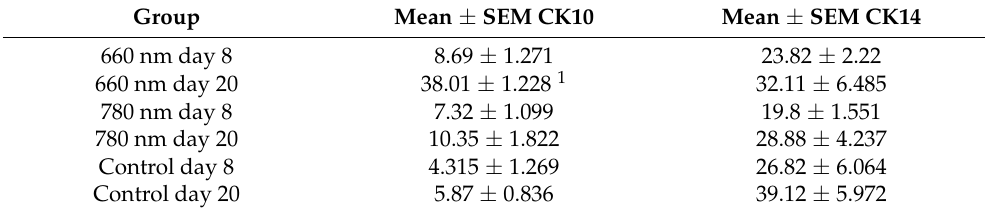
Table 1. Table containing the mean and standard error of the percentage corresponding to the epithelial area marked by CK10 and CK14, according to the experimental groups.